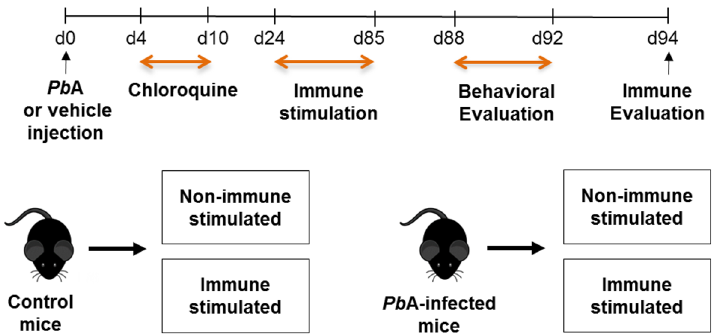
Figure 1. Flowchart of experiments. Groups of mice were infected with Plasmodium berghei ANKA ( Pb A), or mock infected with PBS (Control mice), and treated with chloroquine (25 mg/kg) for 7 days via gavage from the fourth day post-infection. After 14 days, the animals were subdivided into groups of mice immune stimulated with different immunization strategies or non-immune stimulated. Subsequently, mice were evaluated via behavioural tasks for locomotivity, memory and anxiety phenotype. The immune response of randomly chosen mice was